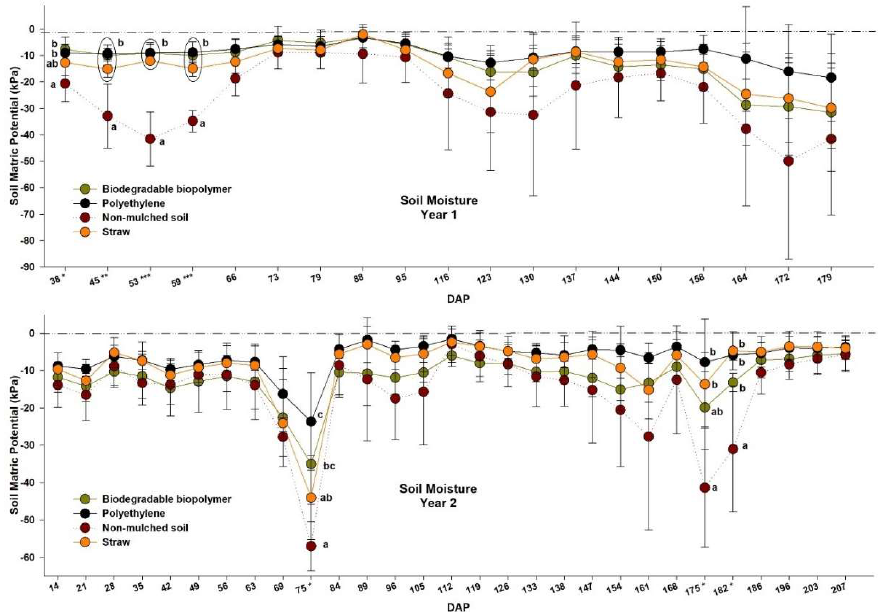
Figure 2. Soil matric potential (kPa) during the two crop seasons (weekly averages) depending on mulch type and in non-mulched soil. Values (mean ± standard deviation; n = 3). Different letters in the same week indicate significant differences ( p ≤ 0.05, Fisher’s LSD test). ‘*’, ‘**’, and ‘***’ indicate significance at p ≤ 0.05, 0.01, and 0.001, respectively. DAP: Days After Planting.